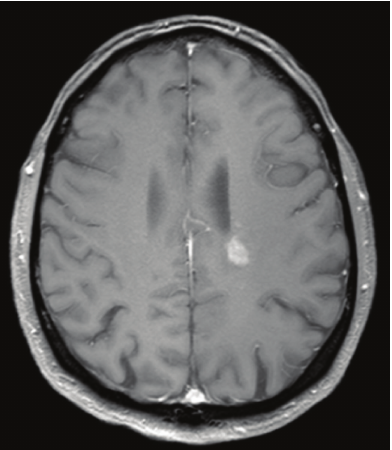
Figure 4: Axial postcontrast T1-weighted brain MRI shows a contrast-enhanced left-sided lesion in the periventricular white matter.